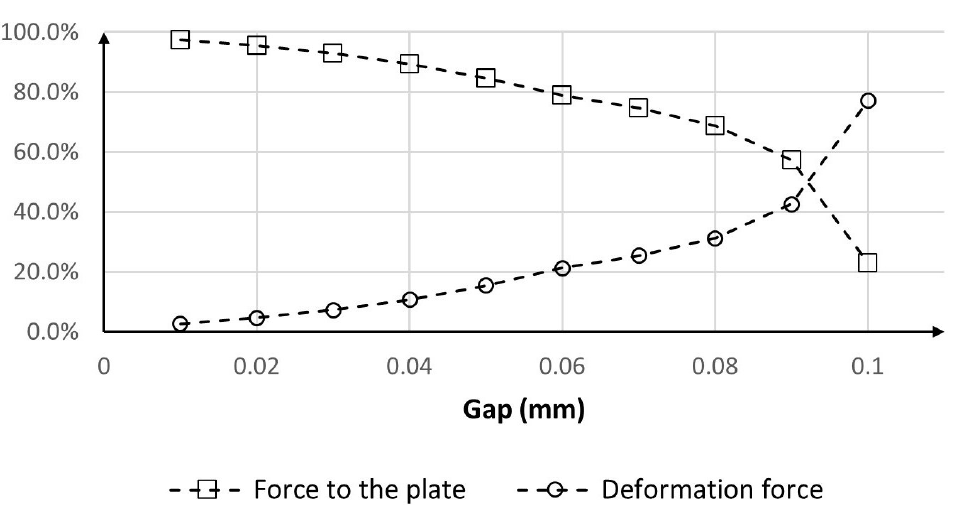
Figure 5. Percent force spent for braking and for piston